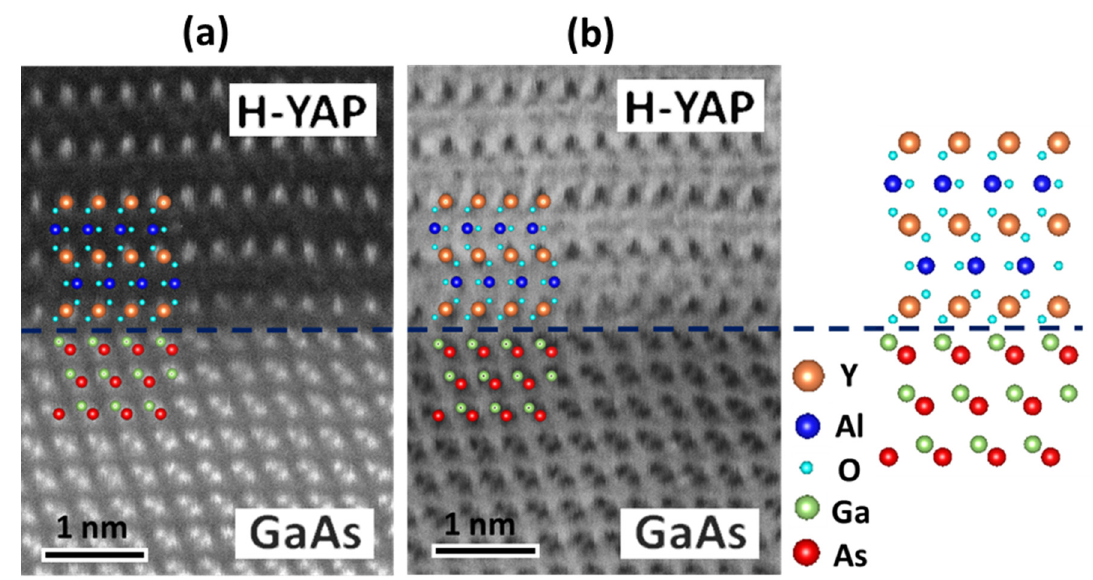
Figure 5. Cross-sectional ( a ) HAADF- and ( b ) ABF-STEM image of enlarged area of H-YAP/GaAs interface of annealed sample A. A dash line indicates the interface between top GaAs and H-YAP. Models of H-YAP and GaAs overlay with the constituents in Figure 5a,b. HAADF- and ABF-STEM images of H-YAP were viewed along [2110] zone axis and those of GaAs were viewed along [110] zone axis.